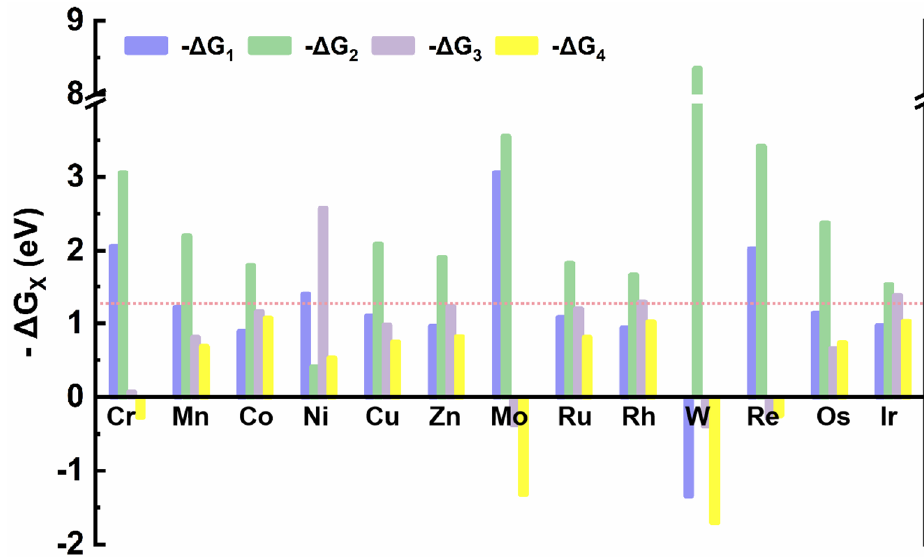
Figure 4. Standard equilibrium potential for reaction steps R1 − R4 for FeMN 6 (I) (M = Cr, Mn, Mo, Ru, W, Re, Os, Co, Ni, Cu, Re, Os, Co, Ni, Cu, Zn, Rh and Ir) moieties. The red dotted line is the ideal reaction free energy at 1.23 eV.